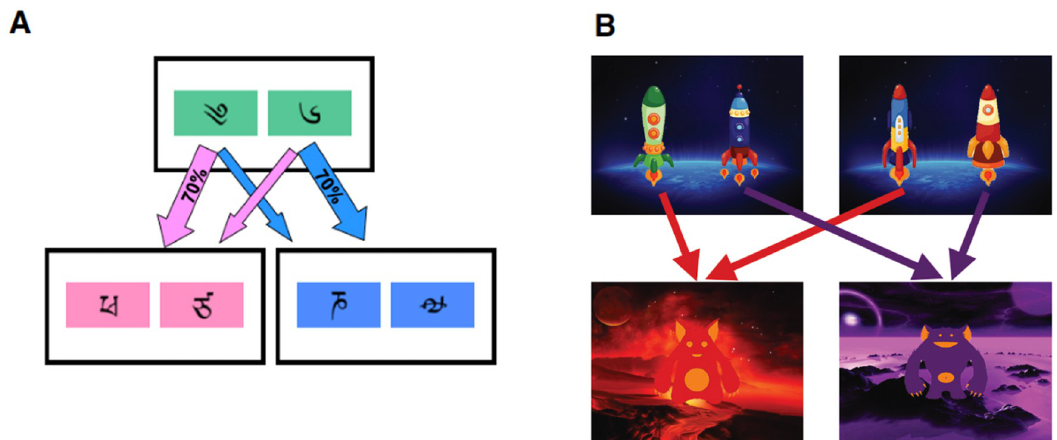
Fig 1. A. Trial structure in the original version of the two-step task. A first-stage choice between two options probabilistically led to a second-stage choice. Each second-stage choice had a randomly varying probability of paying a point or paying nothing. Figure from “Model-based influences on humans’ choices and striatal prediction errors” [4]. https://doi.org/10.1016/j.neuron.2011. 02.027. Used under CC BY 3.0 (https://creativecommons.org/licenses/by/3.0/). B. Trial structure in a newer version of the two-step task where model-based control pays off to a greater degree. Each trial started with one of two pairs of stimuli which participants selected between. The choice led deterministically to one of two second-stage states, with payoffs that varied over the course of the experiment. Figure from “When does model-based control pay off?” [7]. https://journals.plos.org/ploscompbiol/article/figure?id=10. 1371/journal.pcbi.1005090.g015. Used under CC BY 4.0 (https://creativecommons.org/licenses/by/4.0/).